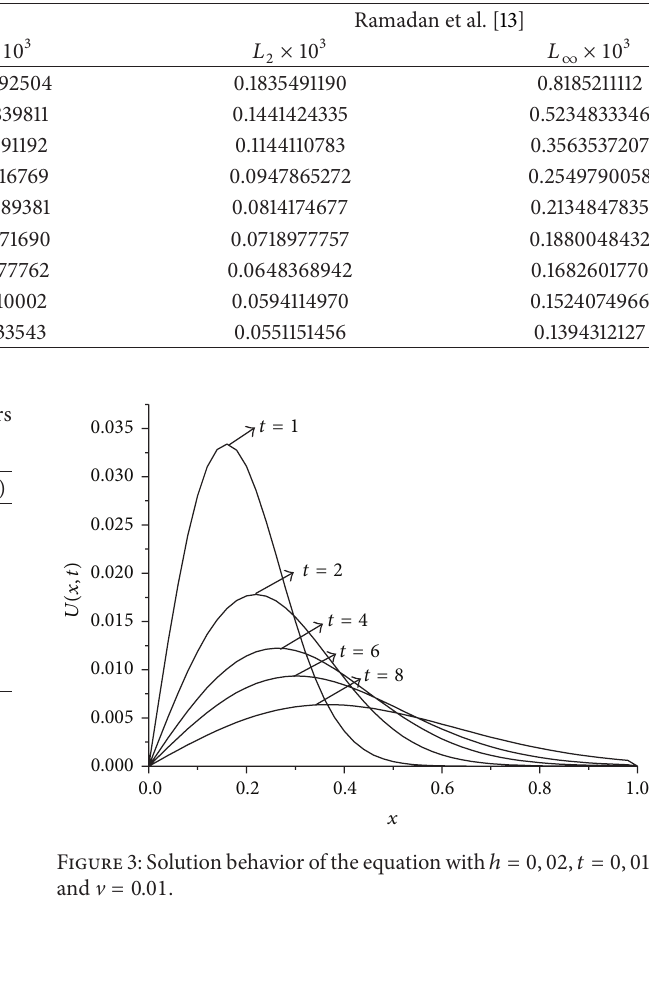
Table 7: 𝐿 2 and 𝐿 ∞ error norms for V = 0.001 , Δ𝑡 = 0.01 , and ℎ = 0.005 .